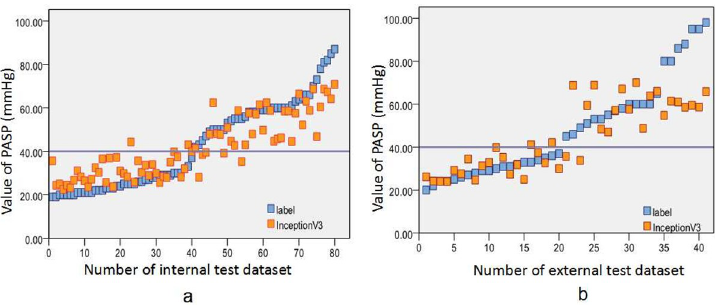
Fig 4. Prediction of exact PASP value by best model (InceptionV3) based on chest radiographs. Prediction of exact PASP value by InceptionV3 model in internal test, with a MAE of 7.45 (a). Prediction of exact PASP value by InceptionV3 model in external test, and the MAE was 9.95 (b). PASP, pulmonary artery systolic pressure; MAE, mean absolute error.